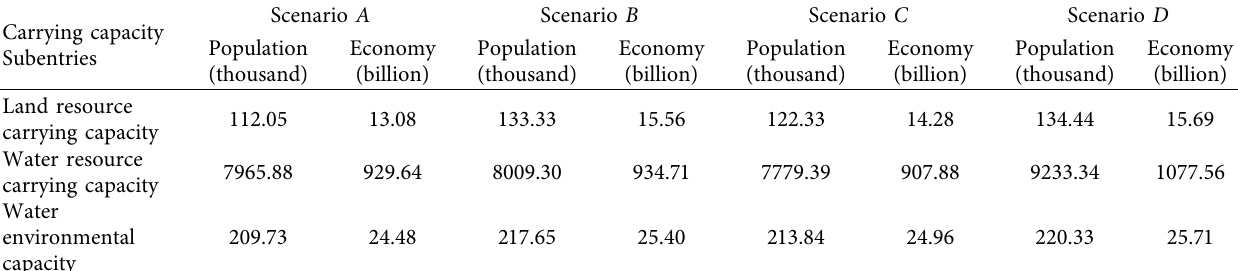
Table 3: Resource environmental carrying capacity (RECC) evaluation in